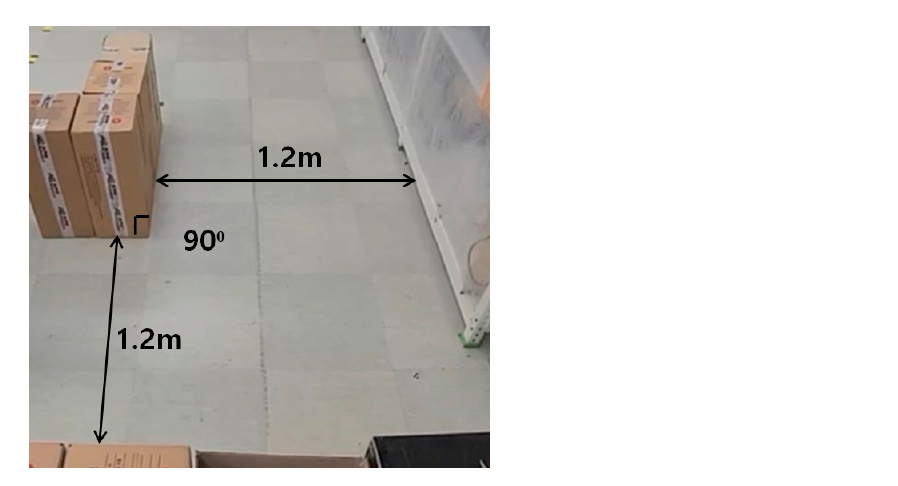
Figure 18. Curve driving test environment in a narrow indoor corridor.